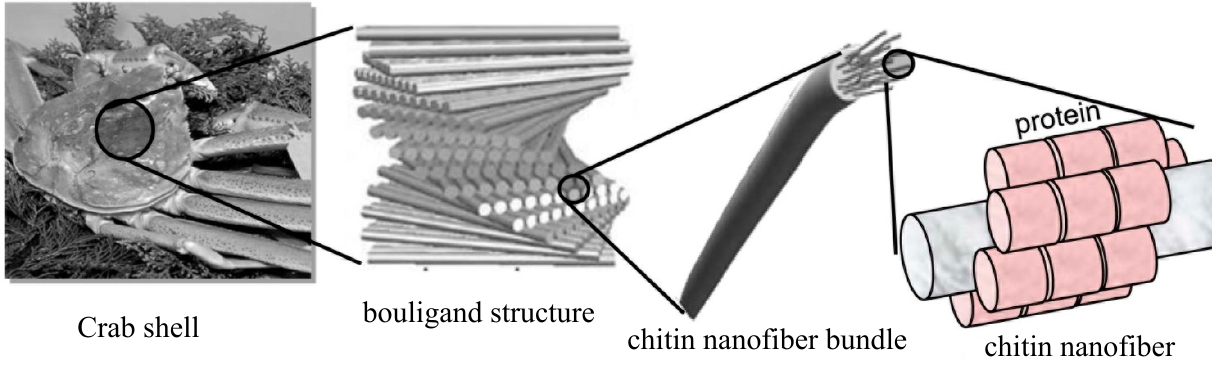
Figure 2. Schematic presentation of the exoskeleton structure of crab shell.